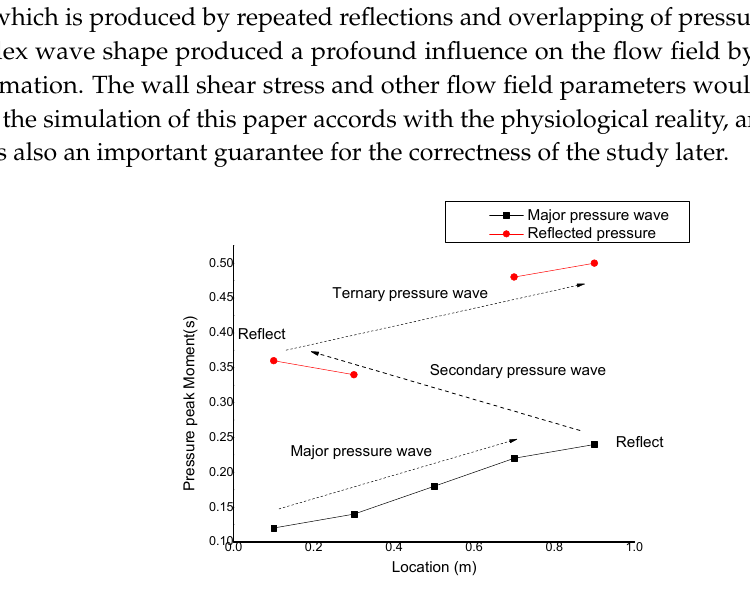
Figure 10. Moments corresponding to major pressure peak and reflection wave peak.